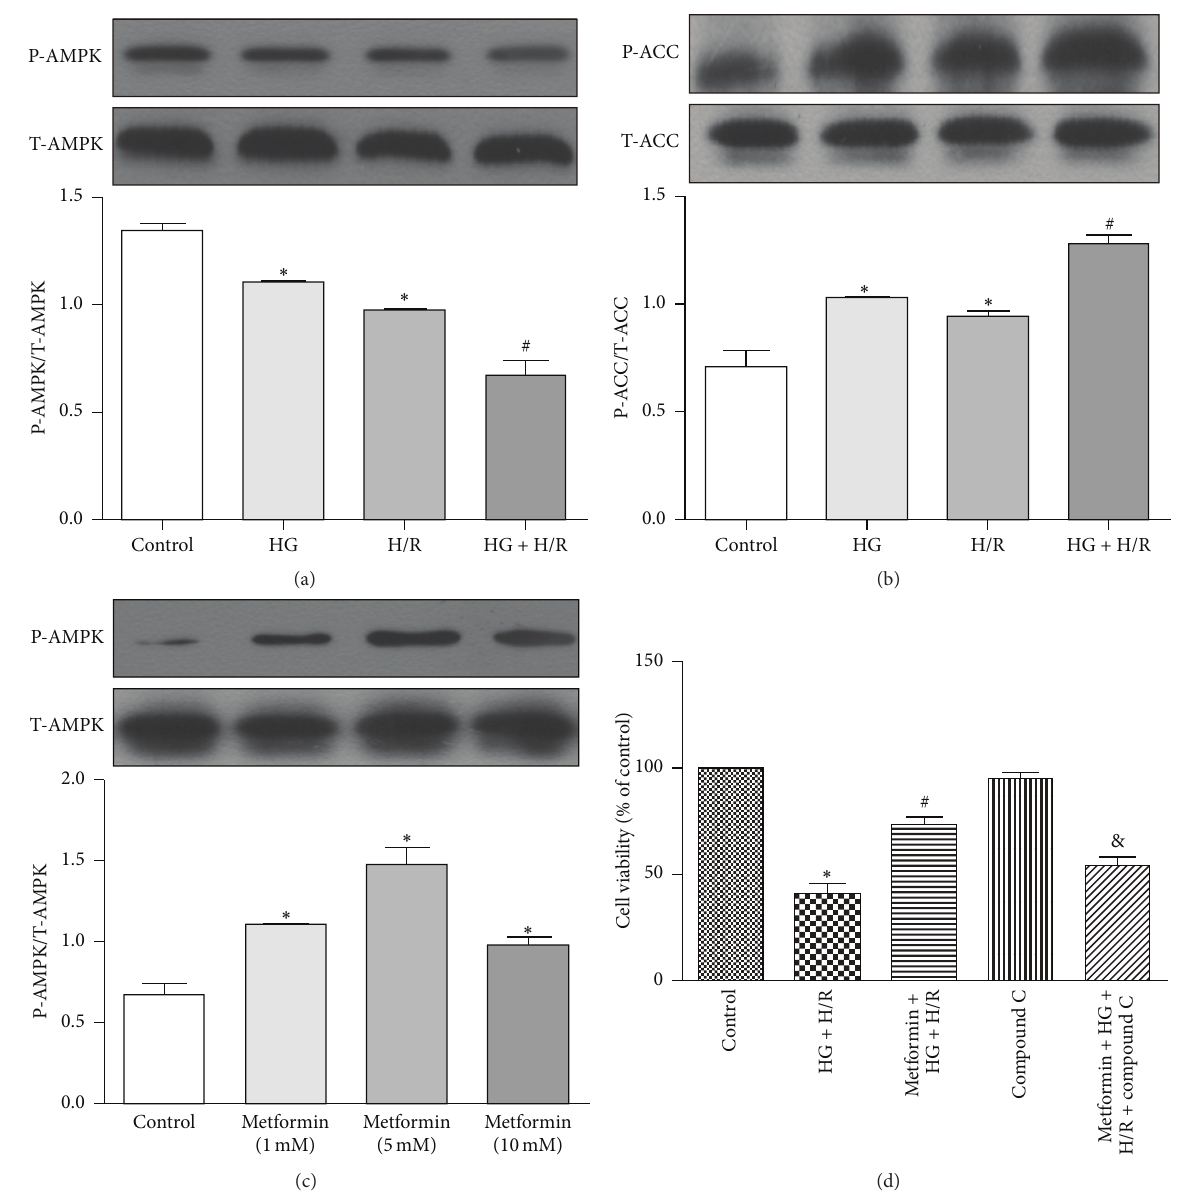
Figure 2: AMPK pathway was inhibited during H/R injury and exacerbated by HG and the cytoprotective effects of metformin were dependent on AMPK activation. H9C2 cells were treated with HG (33 mM), H/R, and HG + H/R. The expression of P-AMPK, T-AMPK (a) and P-ACC, T-ACC (b) was measured by Western blots. (c) Expression of P-AMPK and T-AMPK in the H9C2 cells treated with different concentrations of metformin (0, 1, 5, and 10mM) was measured by Western blots. (d) Cells were treated with HG + H/R, metformin (5 mM) + HG + H/R, compound C (1 𝜇 M), or metformin + HG + H/R + compound C. Cell viability of each group was established using the CCK-8 assay. ∗ 𝑃 < 0.05 versus control; # 𝑃 < 0.05 versus HG or H/R; & 𝑃 < 0.05 versus metformin + HG + H/R. Data are shown as means ± SD of 3 independent